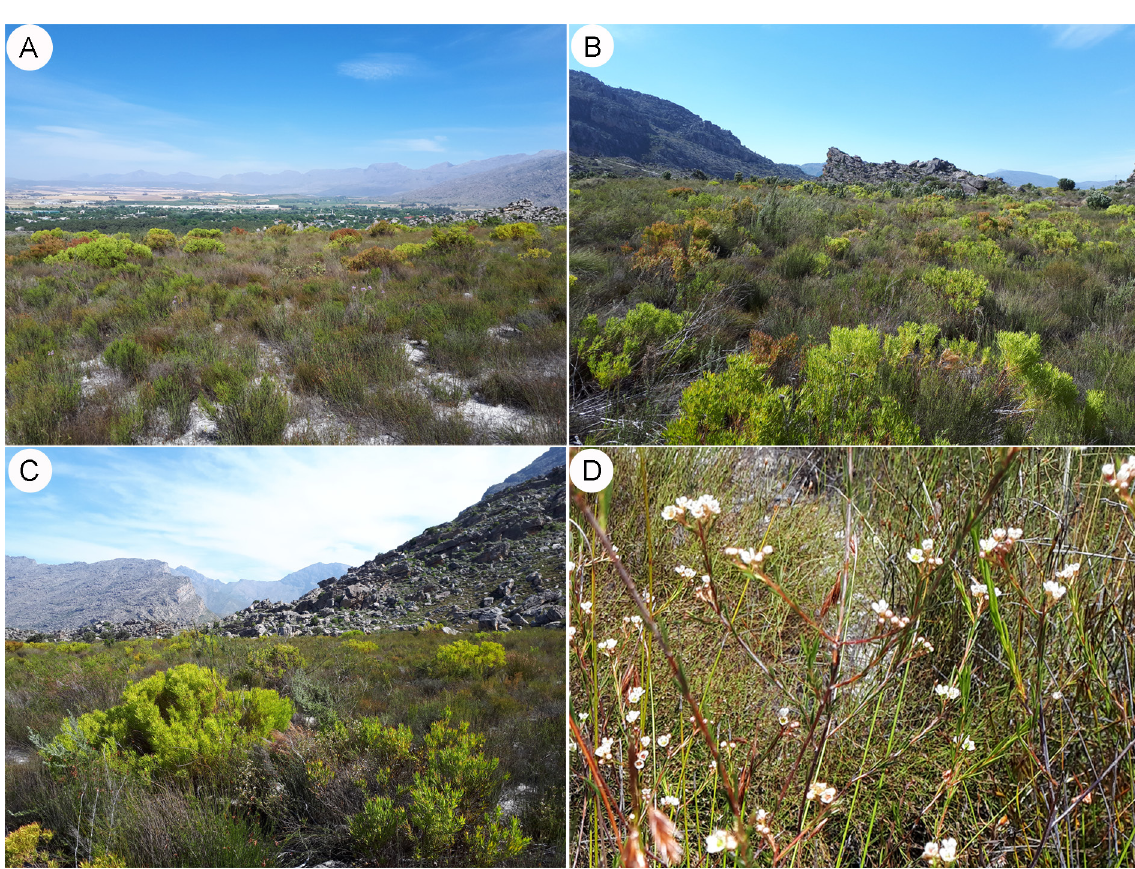
Fig. 26. Habitat of Merodon lotus Vujić & Radenković sp. nov. A–C . Ceres. D . Coleonema sp. Photos by Ante